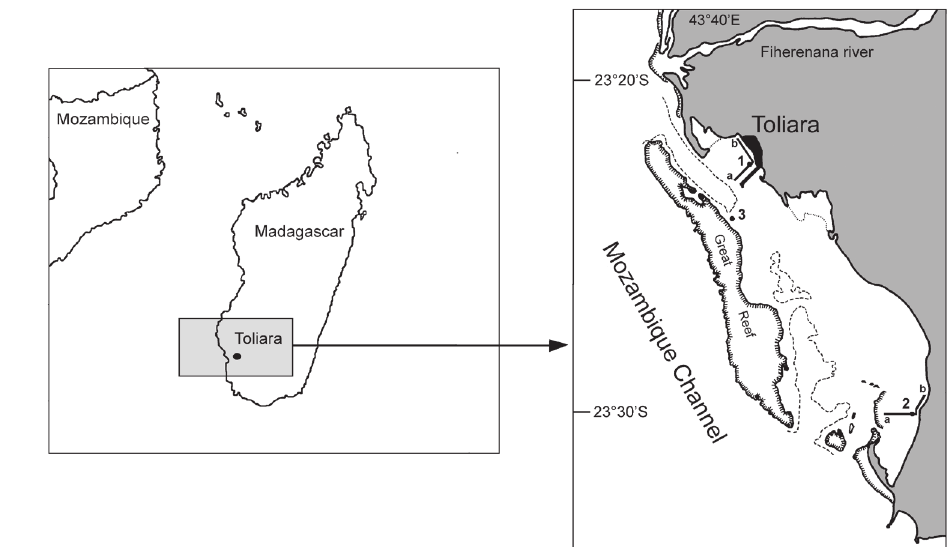
Fig . 1. – sampling locations near toliara (sW madagascar, mozambique channel). numbers refer, respectively, to toliara Beach (1), Beloza mangrove (2), toliara Great reef (3). letters refer, respectively, to the sampling transect across the tidal flat (a) and the sampling transect along the upper intertidal area